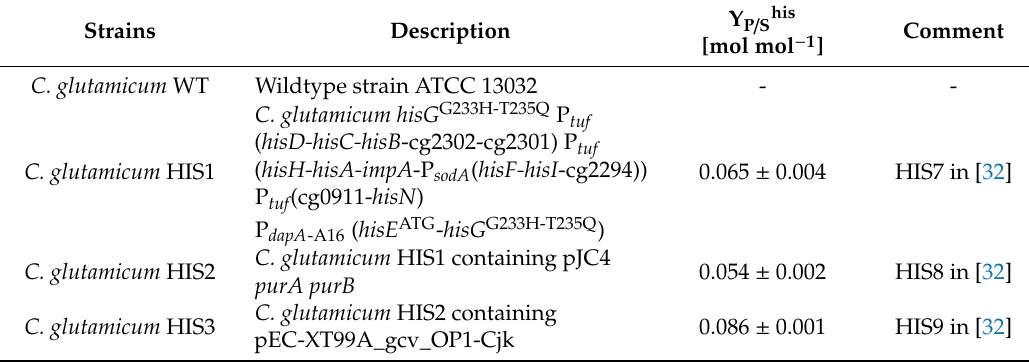
Table 1. Strains that were used in this work and corresponding l -histidine product substrate yields (Y P / Shis